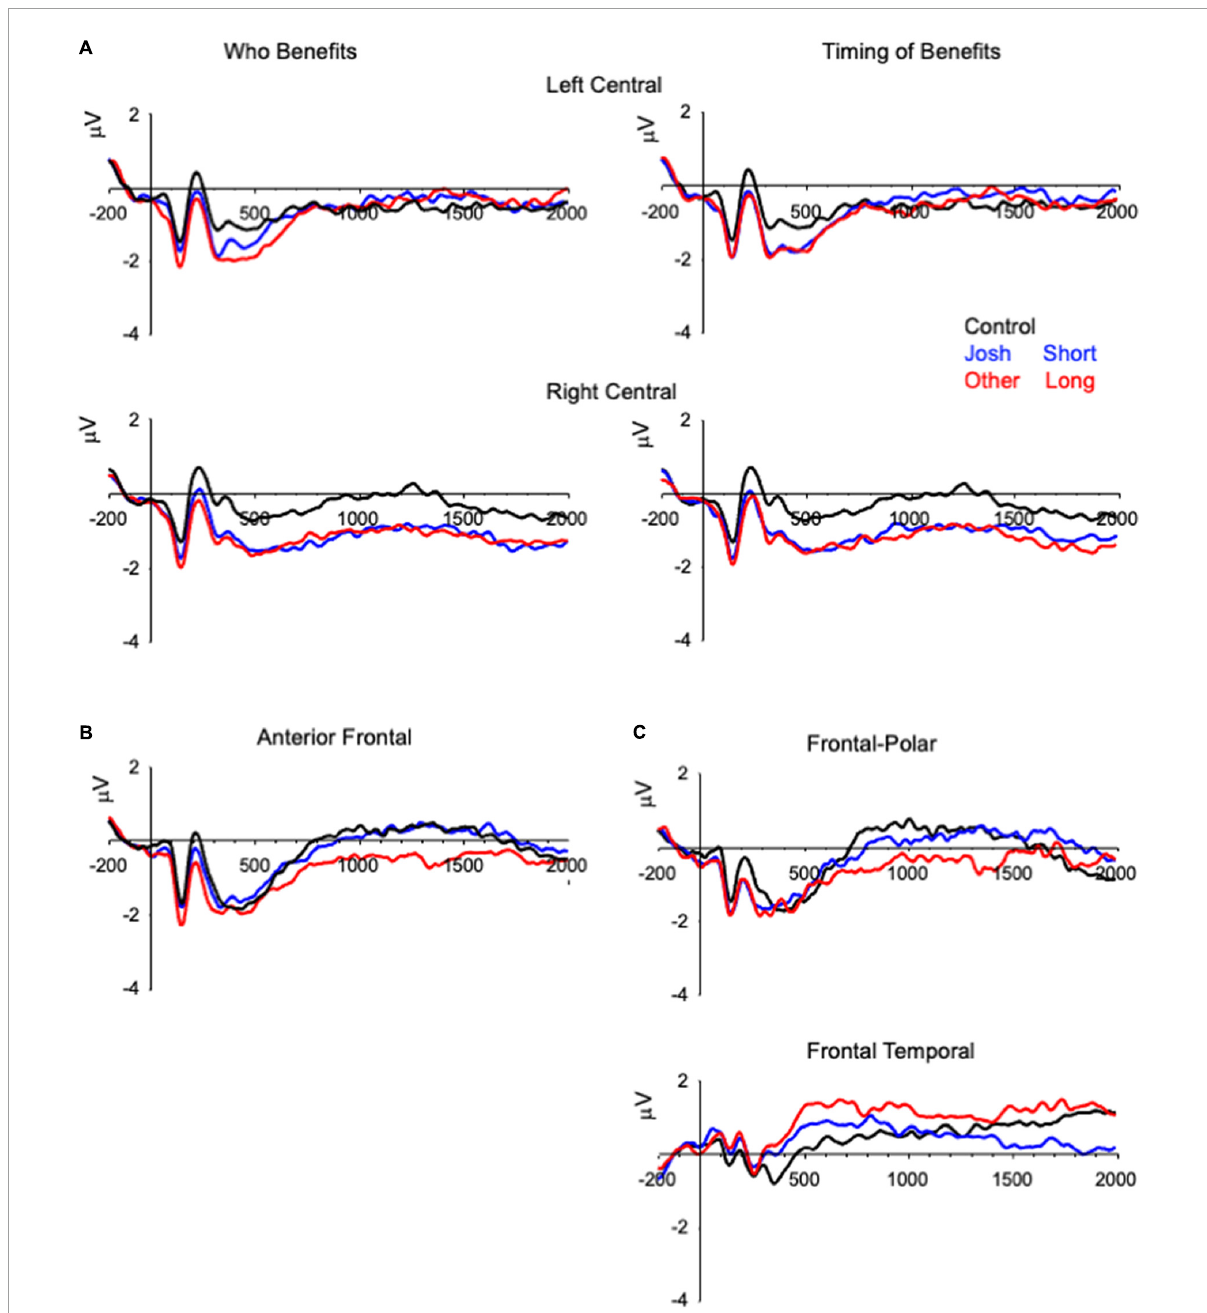
FIGURE2 Grand-averaged ERPs demonstrating differences in the physiology between the two types of trials (i.e., ethical vs. control) that are averaged across the electrodes included in the analyses. (A) The right central slow wave differentiating control items from ethical violation items, (B) anterior frontal slow wave differentiating other items from Josh and control items, and (C) the frontal-polar/frontal temporal slow wave differentiating long delay items from control and short delay items. The ERPs are plotted from 200 ms before onset of the prompt to 2,000 ms after onset of the prompt, and the y-axis represents onset of the prompt.